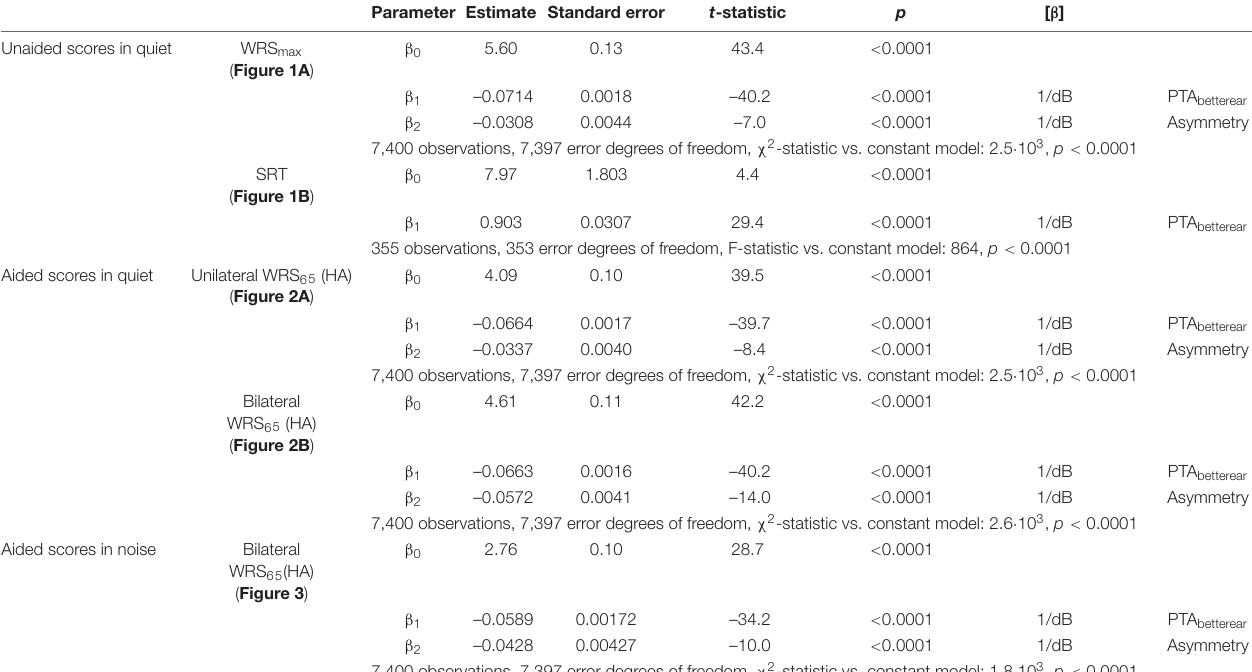
TABLE 2 | Parameters of the generalized linear regression models. Parameter Estimate Standard